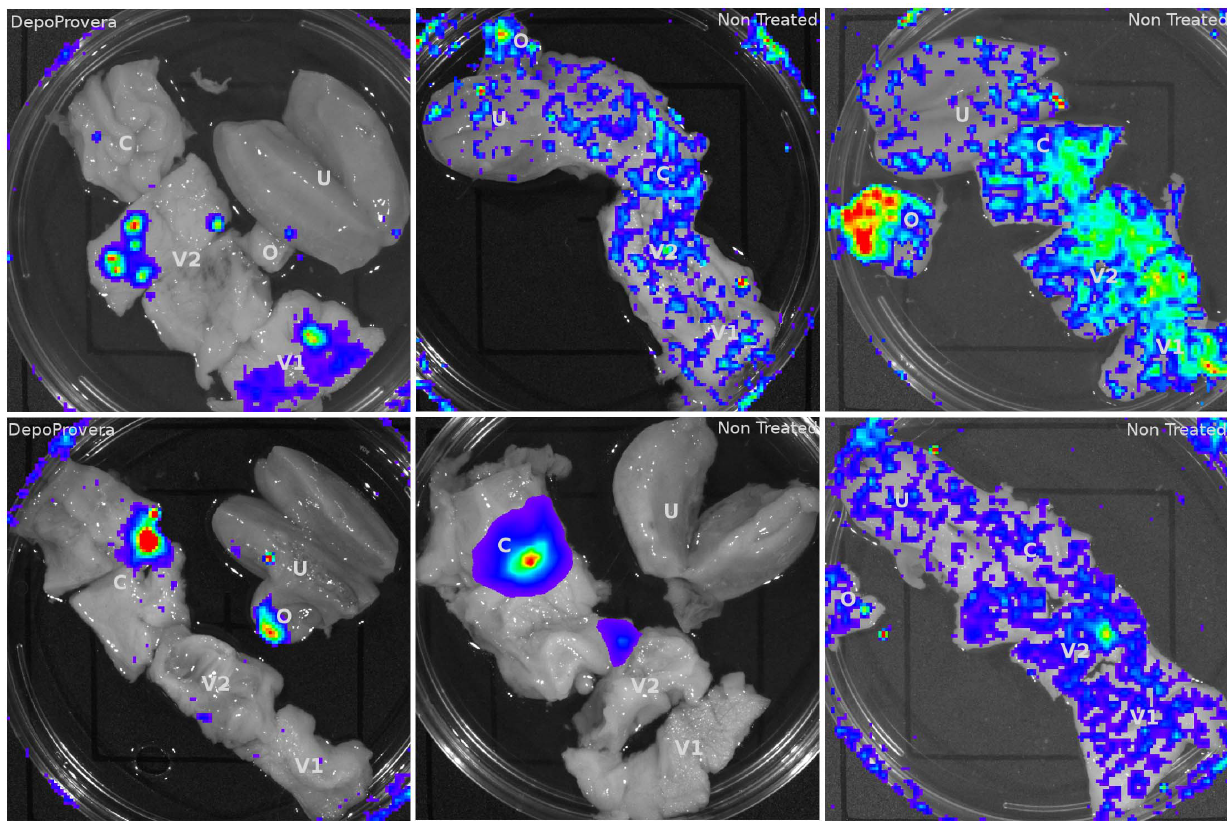
Figure 2. Luciferase reporter expression throughout the female reproductive tract in VSV-G pseudotyped vector inoculated Rhesus Macaques. 6 animals (4 pretreated with Depo-Provera) were inoculated with VSV-G pseudotyped dual-reporter vectors and sacrificed 48 hours later. Exposure to luciferin reveals reporter expression is present throughout the reproductive tract of Depo-Provera treated and normally cycling monkeys and that expression pattern varies between animals.